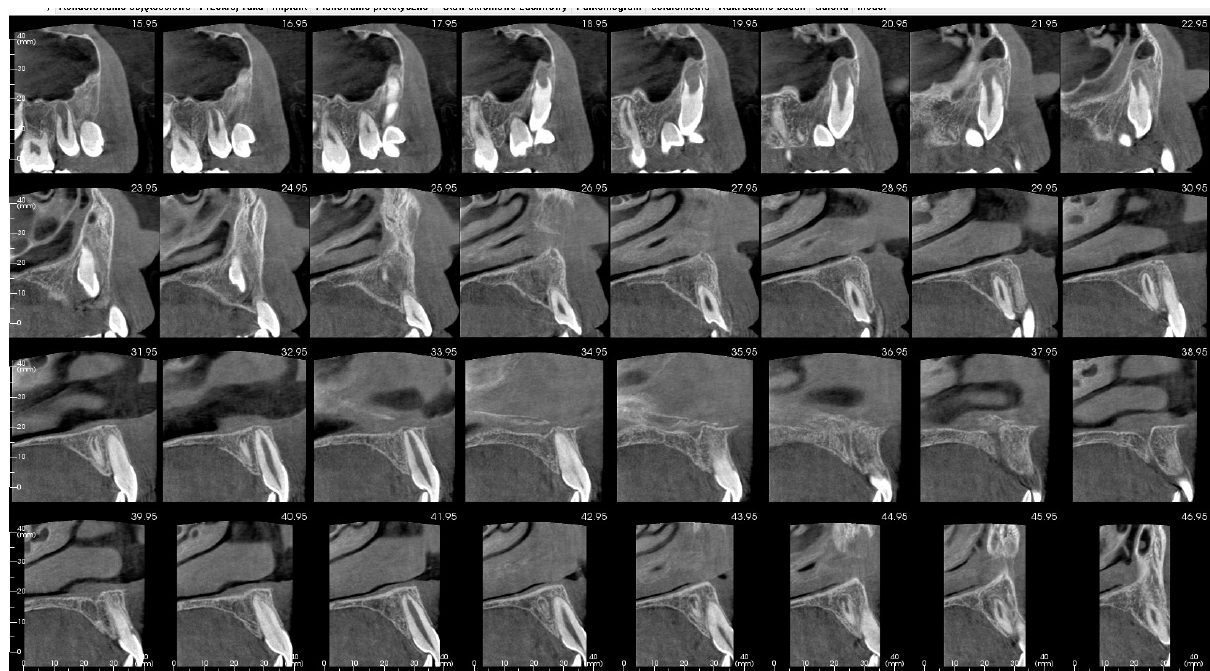
Figure 7. OPG 3 months after surgery.